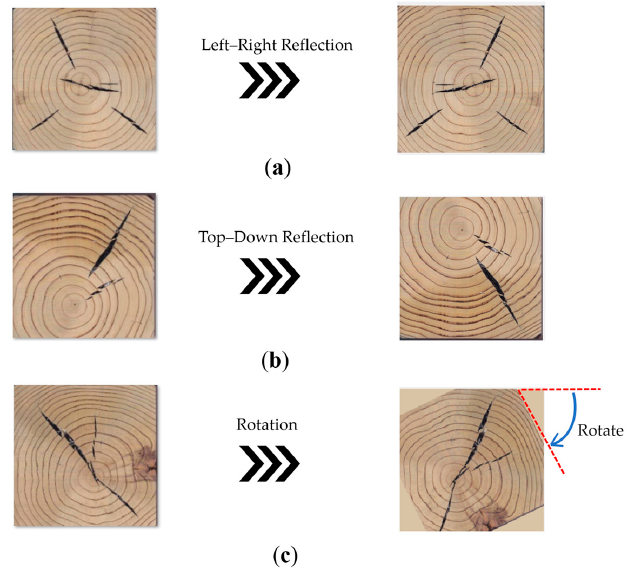
Figure 10. Augmentation of training images. ( a ) Left–Right Reflection; ( b ) Top–Down Reflection; ( c ) Random rotation.